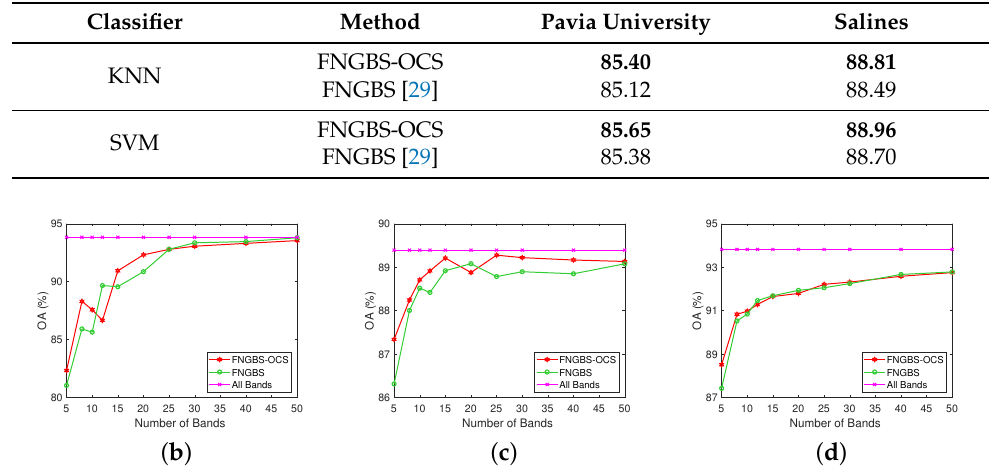
Table 5. AOA of KNN on Pavia University and Salines (%).